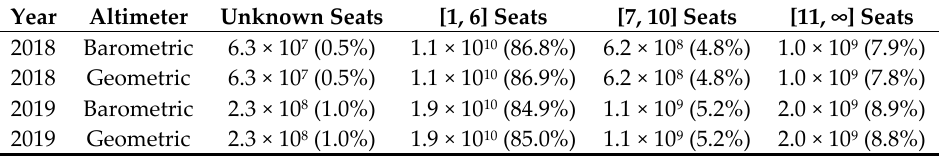
Table 3. Frequency of fixed wing single engine operating at or below 18,000 feet AGL.